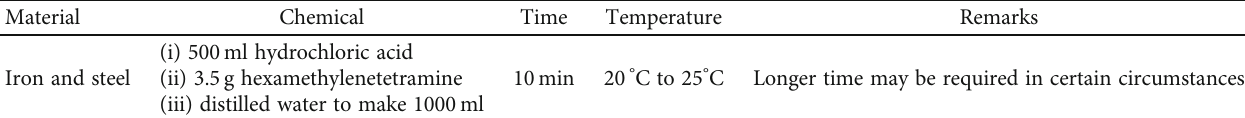
Table 2: Chemical cleaning procedure and solution for removal of corrosion products.